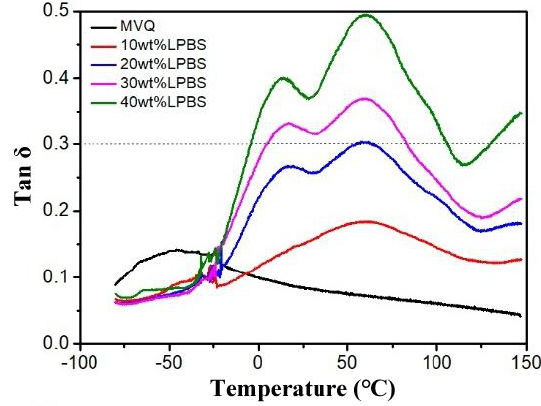
Figure 4. DMA curves of PBS-gel/MVQ composites tested at 1 Hz.